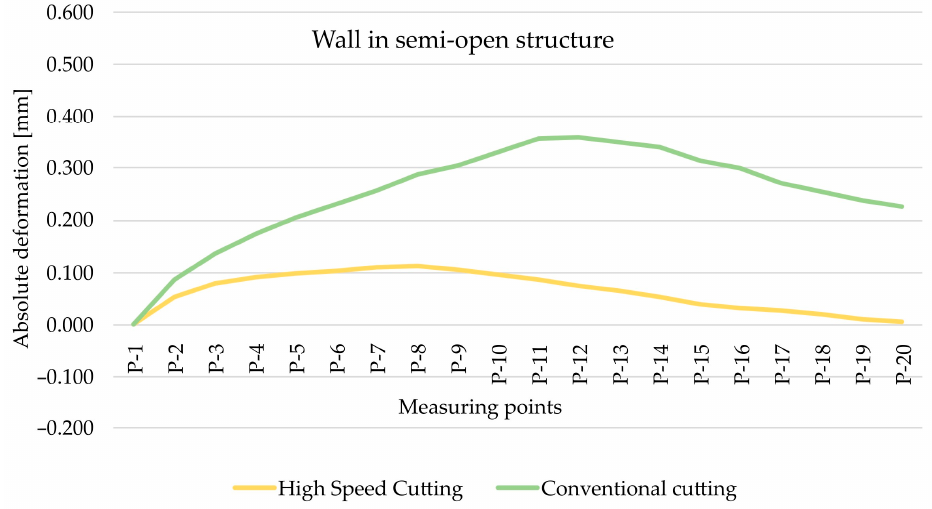
Figure 15. The comparison of absolute deformation for individual measurement points depending